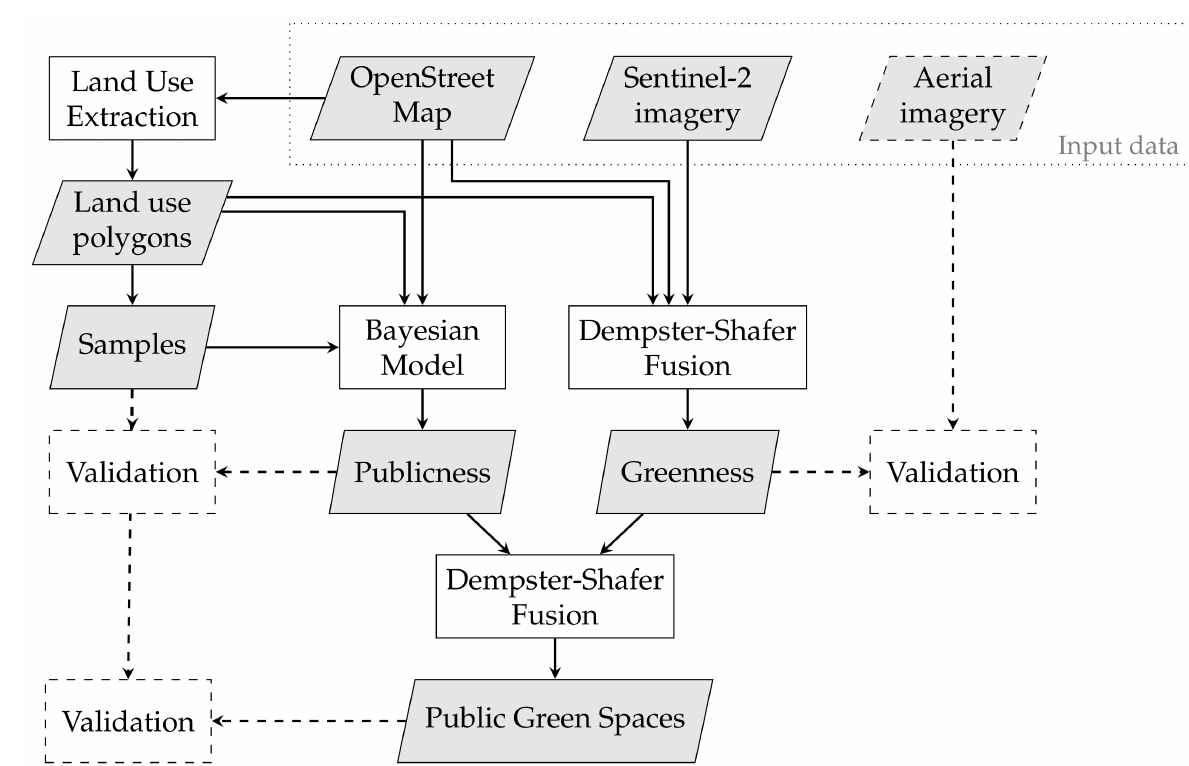
Figure 2. Conceptual workflow for mapping public urban green spaces. Grey boxes represent input or intermediate data, white boxes represent processes, dashed lines and boxes represent validation